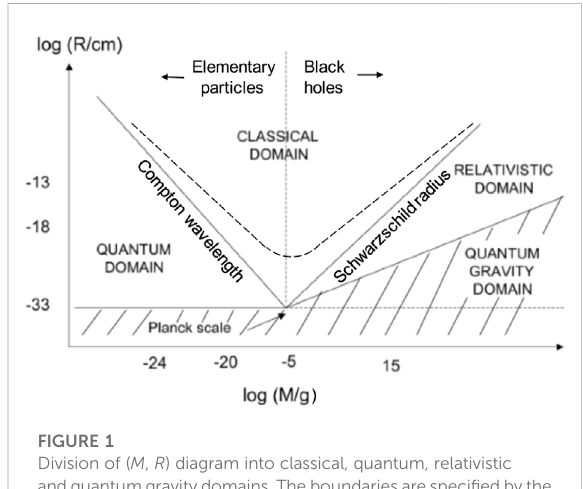
FIGURE 1 Division of ( M , R ) diagram into classical, quantum, relativistic andquantumgravitydomains. The boundariesarespeci fi edbythe Planck density, Compton wavelength and Schwarzschild radius. From Carr